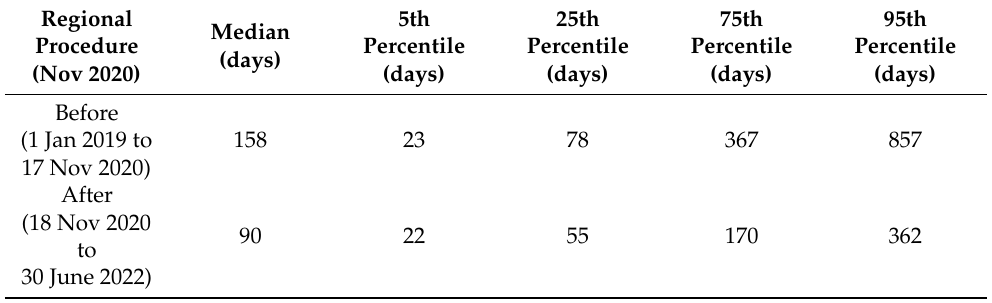
Table 6. Median time to the provision of care (i.e., days elapsing between a diagnosis of CIN2+ lesion at 1st-level screening and the administration of a first dose of HPV vaccine), and percentiles, before and after the introduction of the regional